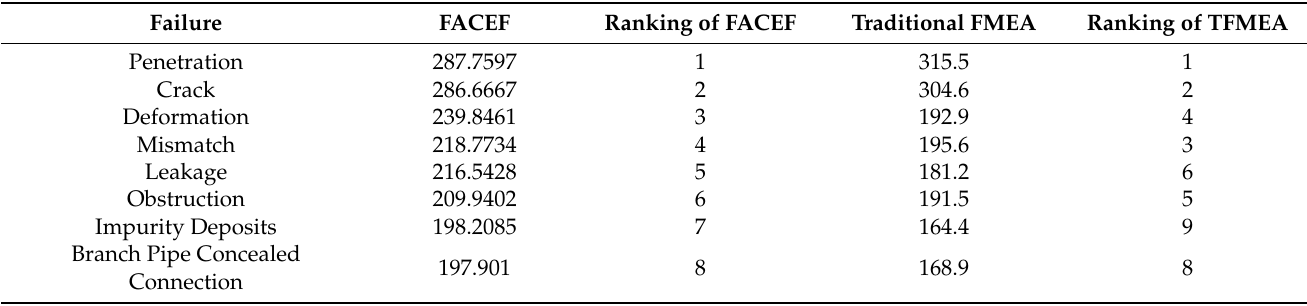
Table 10. Ranking of sewer pipe failures by using FACEF and